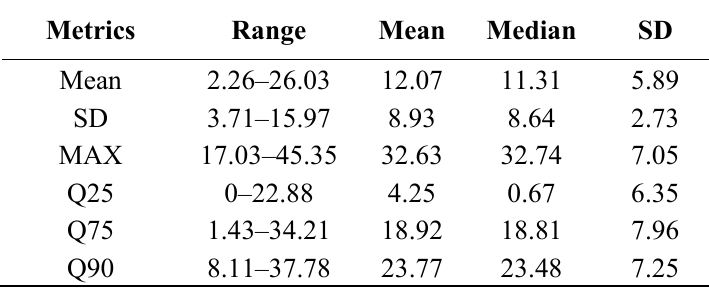
Table 3. Summary statistics of the CHM metrics calculated at the 67 terrestrial sample plots (in